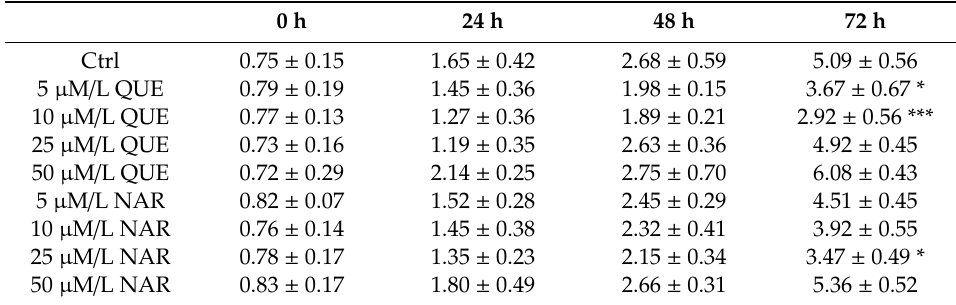
Table 6. The e ff ect of quercetin and naringenin on the amount of protein carbonyls (nmol / mg protein) in extended boar spermatozoa ( n = 28).